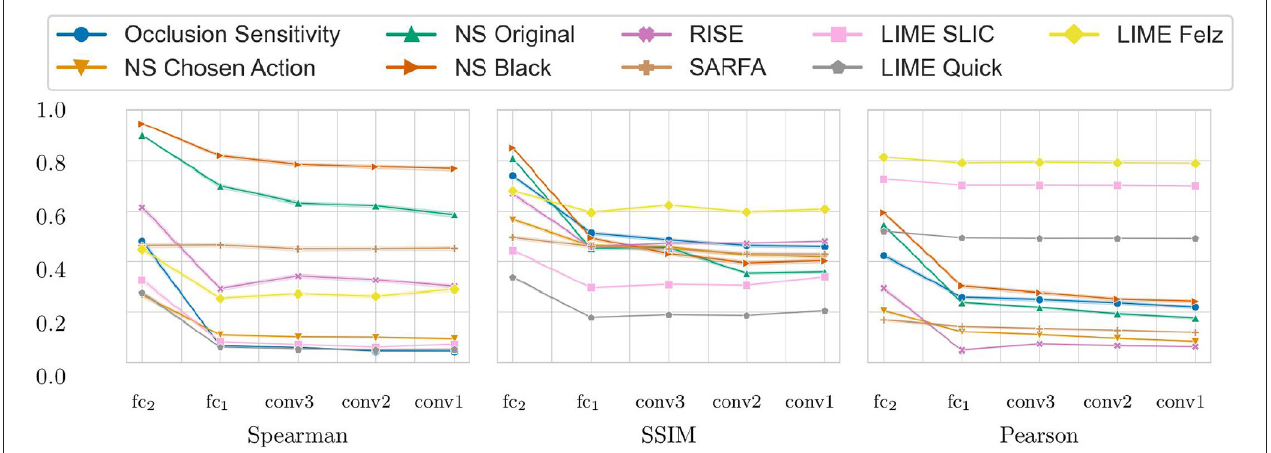
FIGURE 5 | Results of the sanity checks for the different saliency map approaches ( NS is noise Sensitivity). Measured for 1,000 states of each of the 4 tested games. Starting from the left, each mark represents an additional randomized layer starting with the output layer. The y-axis shows the average similarity values (Spearman rank correlation, SSIM, Pearson correlation of the HOGs). High values indicate a low parameter dependence. The translucent error bands show the 99% CI but are barely visible due to low variance in the